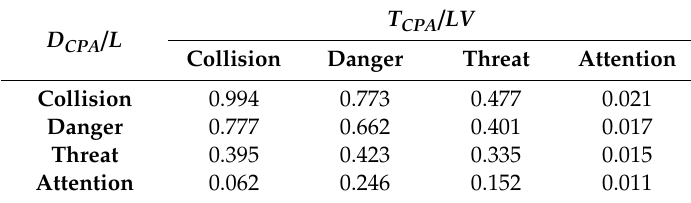
Figure 6. Surface of the T1FIS-NC. Table 2. Fuzzy inference rule of the T1FIS-NC.